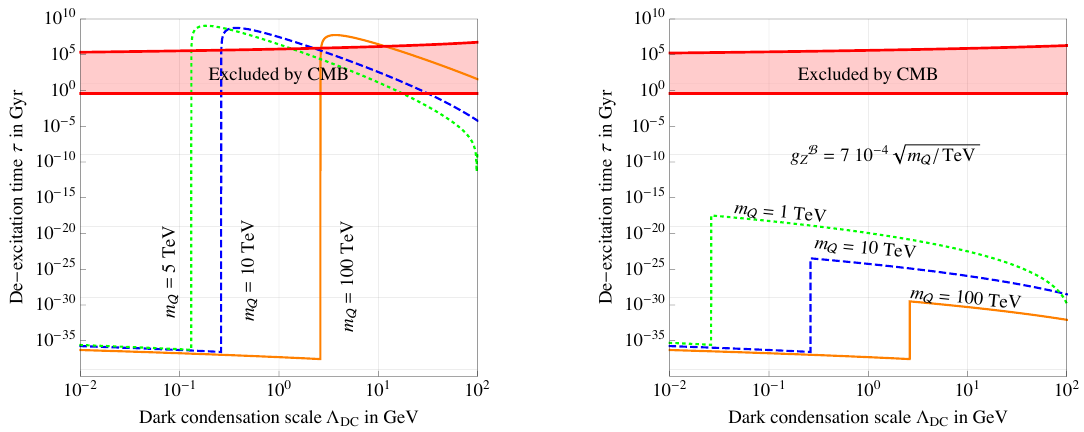
Figure 10 . De-excitation life-time of radio-active dark matter, that can be long when M is larger than the binding energy. A very long (cid:28) is obtained when the life-time of dark glue-balls is so long that they dilute the DM density. In the left (right) panel glue-balls decay thanks to heavier dark quarks charged under G SM (with a Yukawa coupling y to the Higgs). Bounds from energy injection in the CMB spectrum are